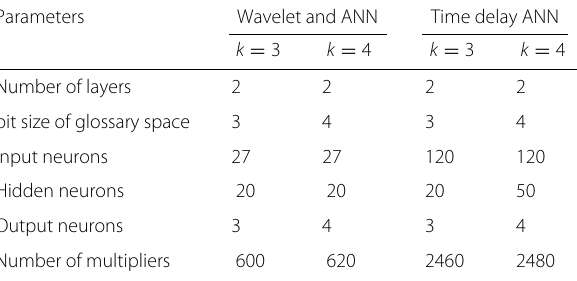
Table 8 Space complexity comparison between the proposed approach and time delay ANN